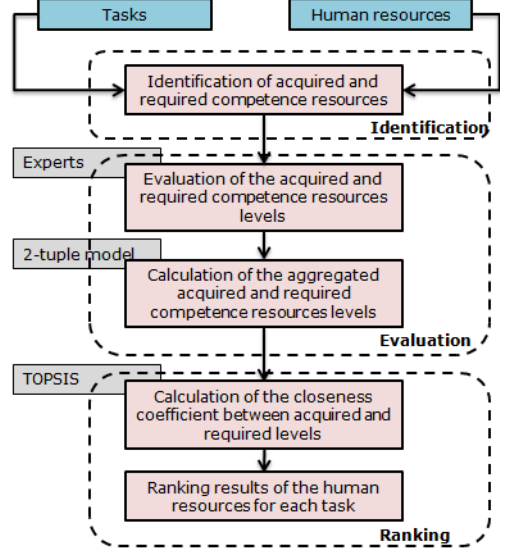
Figure 1. The proposed